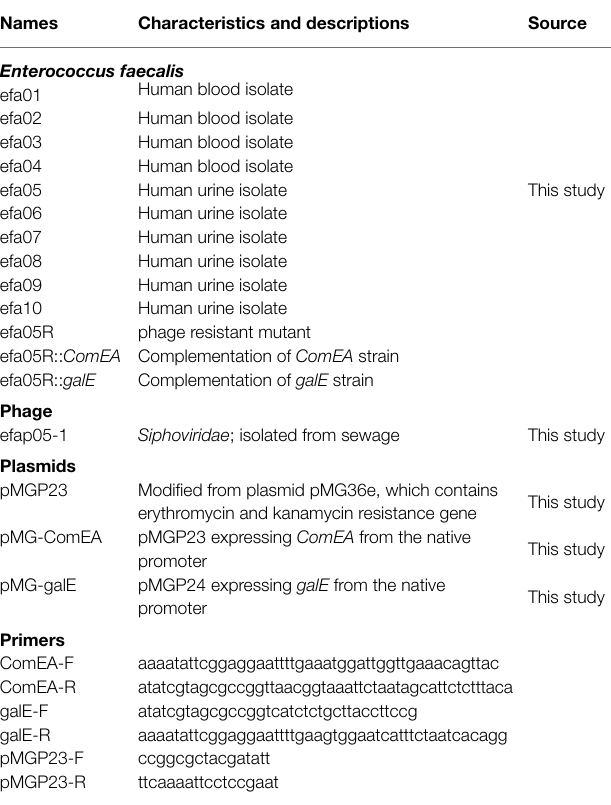
TABLE 1 | Bacterial strains, phages, plasmids, and primers used in this